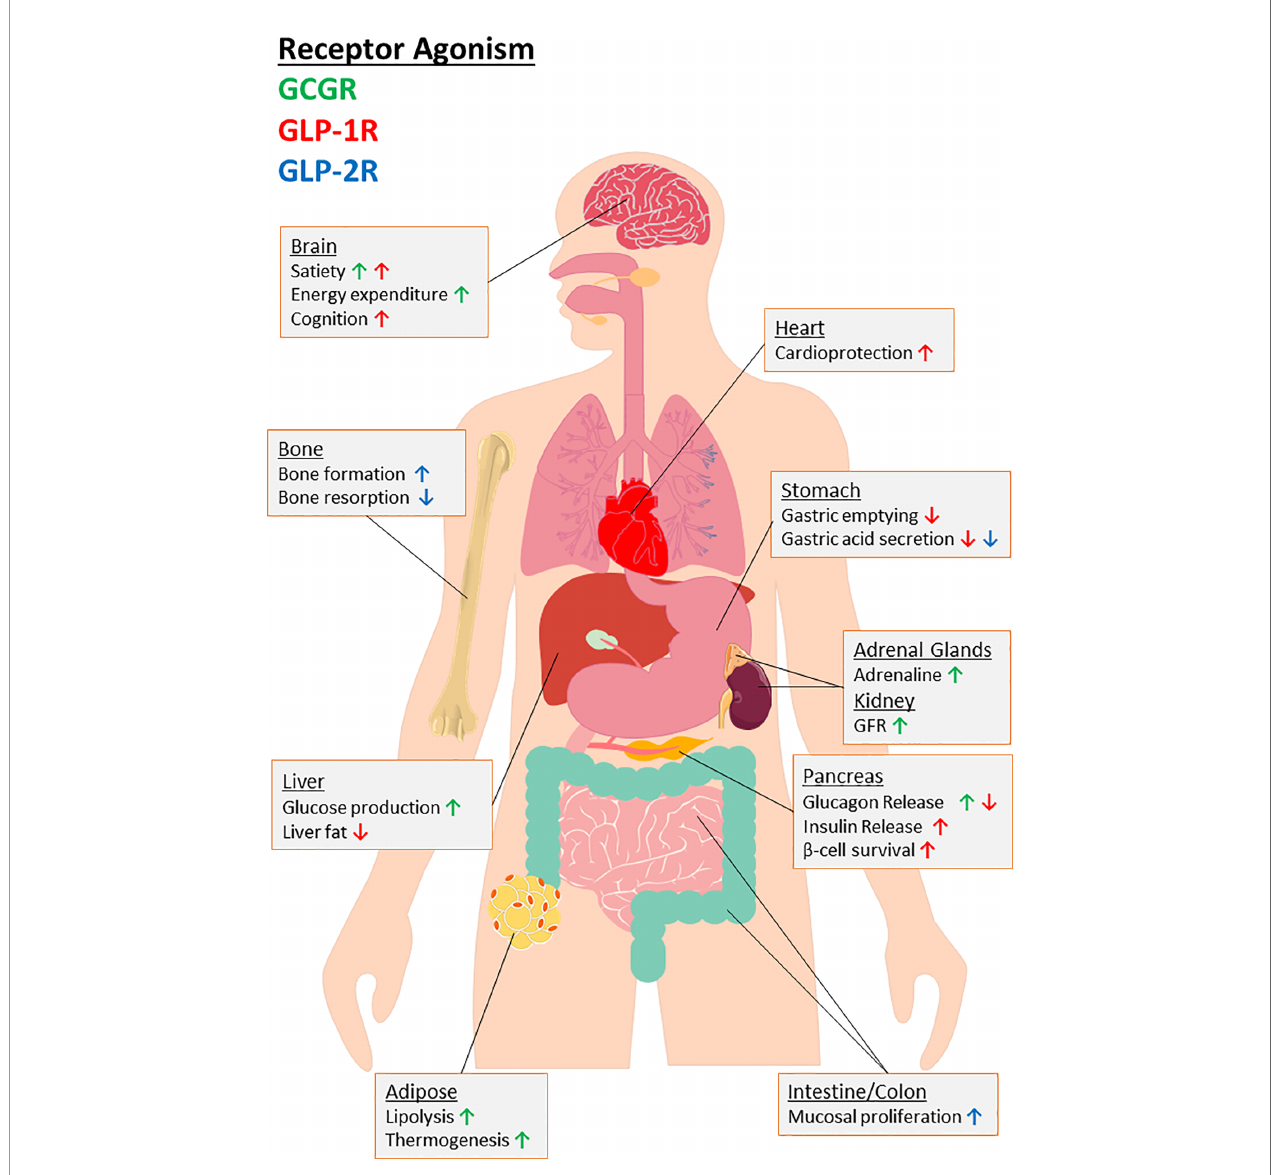
FIGURE 3 | An overview of the biological consequences for agonism of target receptors of major PGDP ’ s, namely glucagon receptor (GCGR) and glucagon-like peptide-1 and -2 receptors (GLP-1R, GLP-2R). Organ-speci fi c actions are provided with arrows indicating up or downregulation of speci fi c effects to highlight the therapeutic potential for multiagonism in relation to PGDP ’ s. As indicated by the key, the colour of arrow indicates the receptor interactions responsible. “ GFR ” indicates glomerular fi ltration